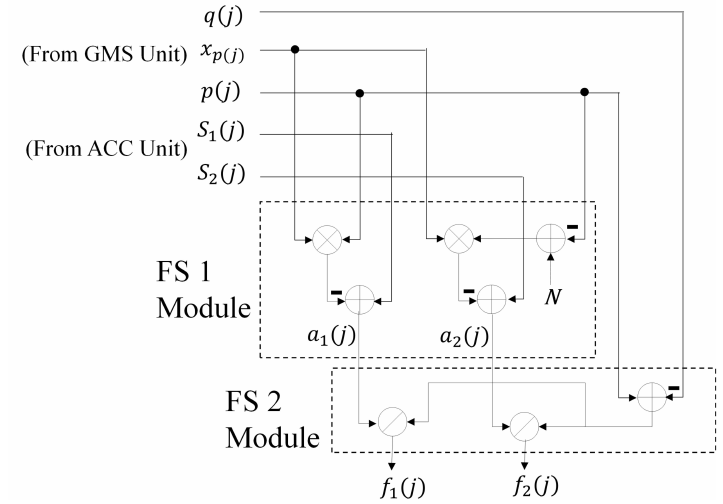
Figure 8. The architecture of the FS